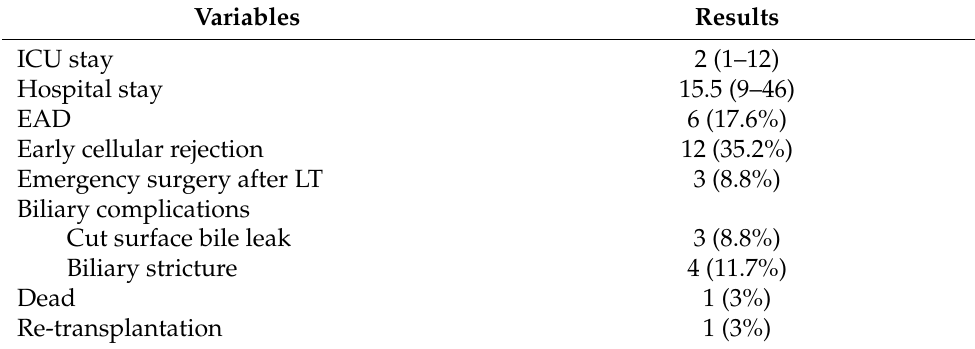
Table 4. Postoperative